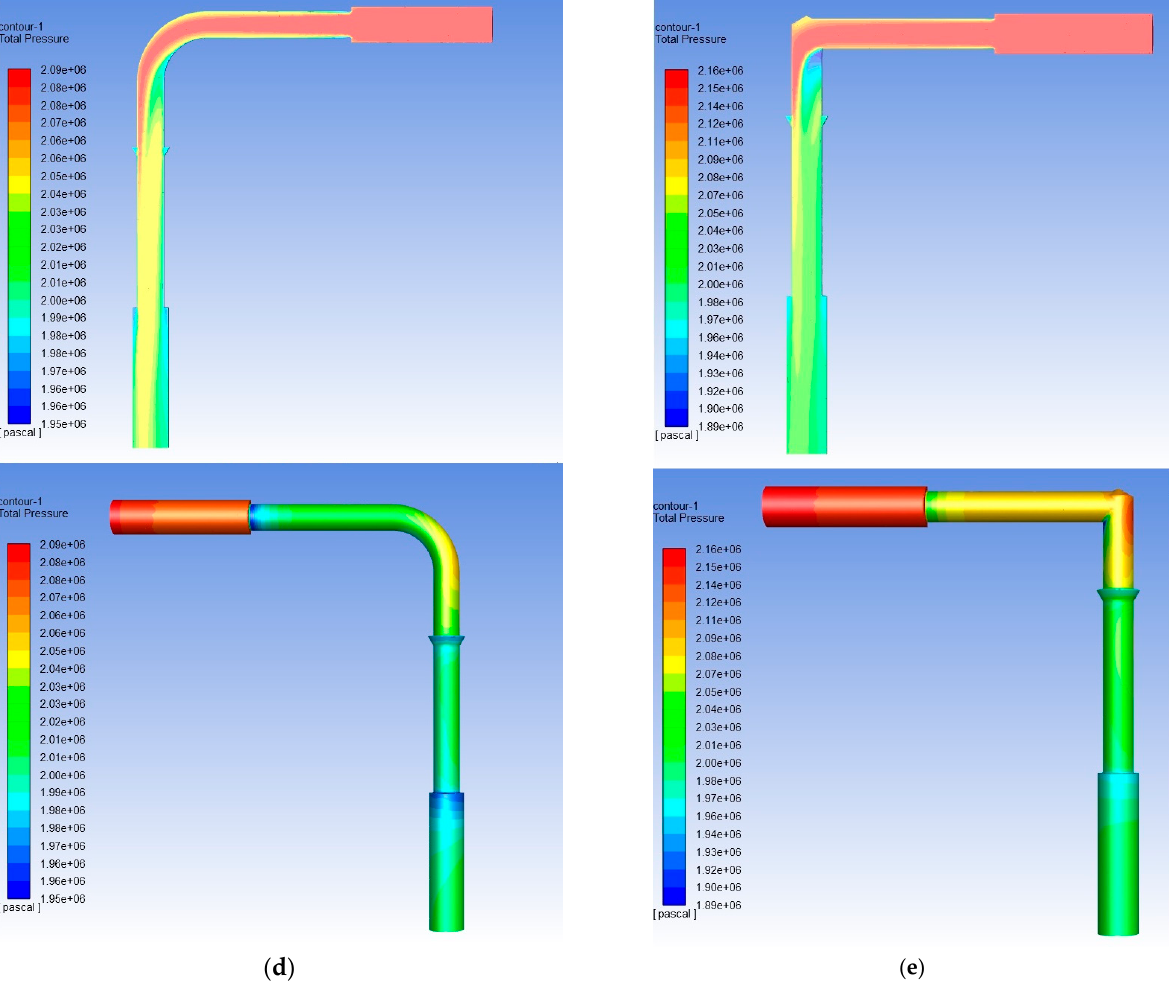
Figure 7. View of the total fluid flow pressure across angular fitting connections (top—symmetry side; bottom—wall side): ( a ) equivalent length method; ( b ) DKR 45° connection; ( c ) DKR 45°K connection; ( d ) DKR 90° connection; ( e ) DKR 90°K connection.